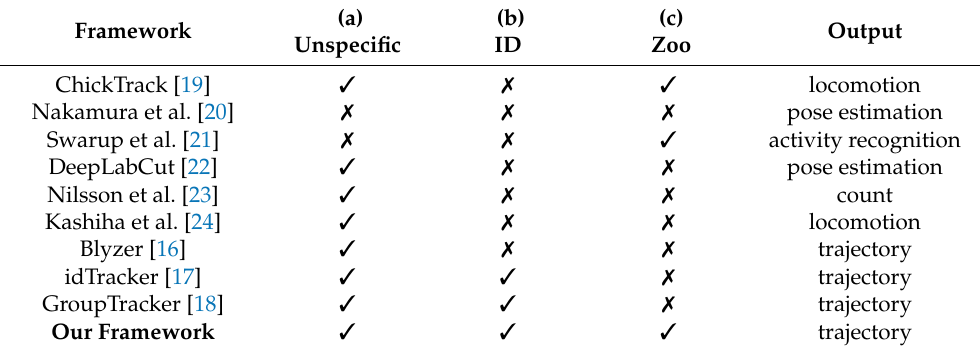
Table 1. Current video-based frameworks for animal behavior monitoring. They are listed accord- ing to the requirements that must be addressed for the present zoo setting: (a) species-unspecific approach; (b) identification of individuals; (c) applicable in the zoo setting (varying camera angles, low camera resolutions, varying light conditions, large enclosures); the last column lists the extracted behavioral